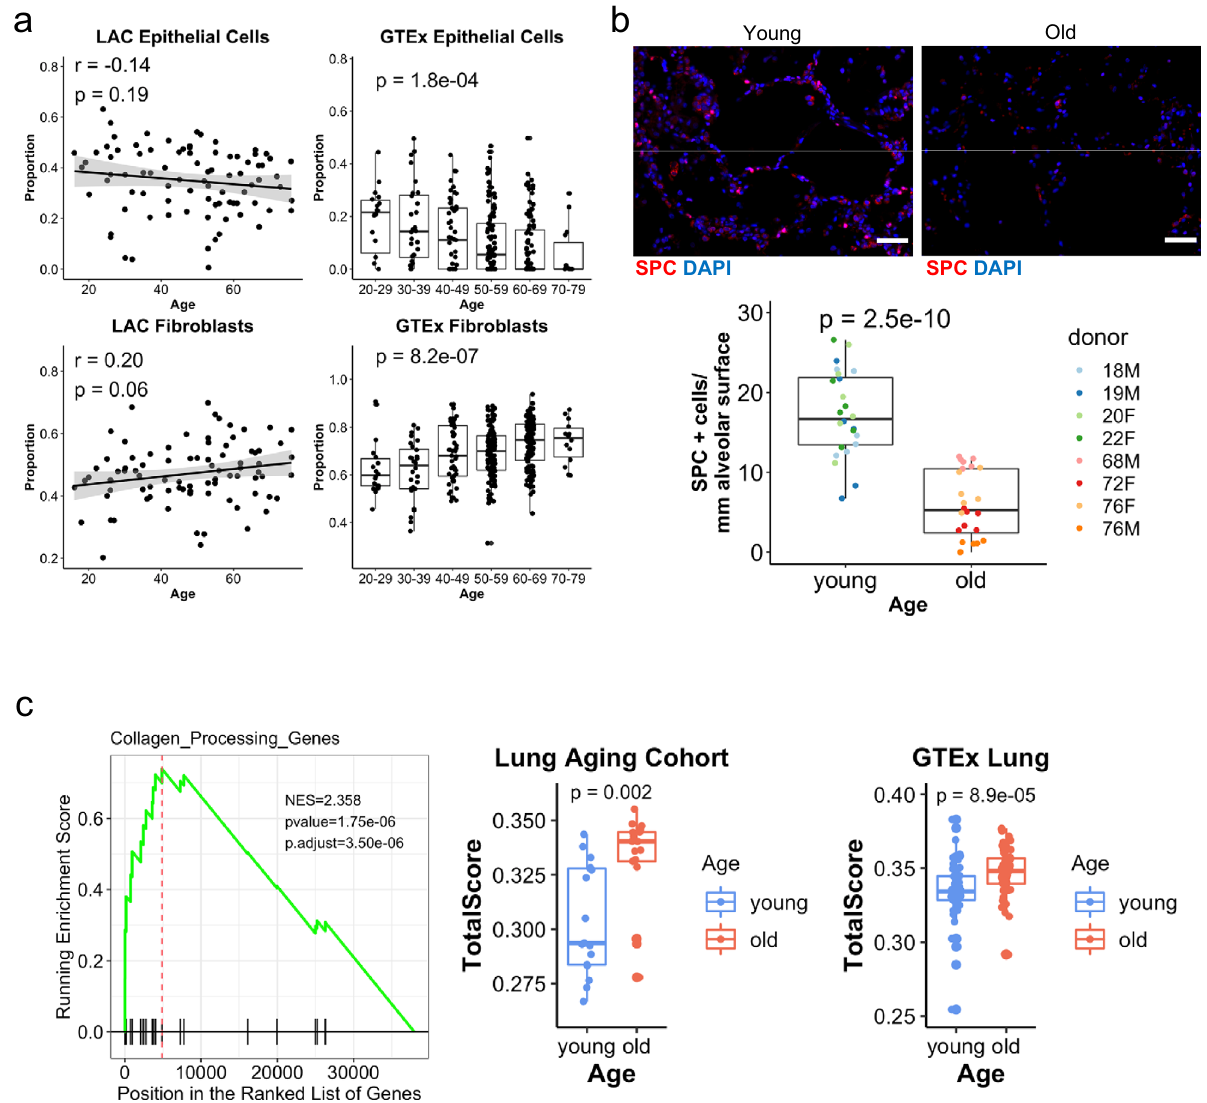
Fig. 3 Fibrotic programs in lung aging. a Cell type deconvolution of bulk RNA-seq data from the LAC ( N = 86 biologically independent samples) and GTEx lung ( N = 345 biologically independent samples). Age for GTEx is represented in decades. Pearson R and P values are shown for LAC, and one-way ANOVA is shown for GTEx. The gray bands represent 95% con fi dence intervals. b Quanti fi cation of type 2 cells in old and young lungs by labeling of SPC + cells, with representative images (Scale bars: 50 µ m) ( N = 4 biologically independent samples in each group, N = 6 images examined per sample). Donor age and gender are shown. Each point represents the number of SPC + cells in a separate image, adjusted for alveolar membrane length. P value is for a two-tailed Student ’ s t -test comparing all dots from the old versus the young. c Collagen-processing gene expression in the LAC by gene set enrichment analysis. Genes were ranked by Pearson R between normalized gene expression and age. Normalized enrichment score, P value, and adjusted P value are shown. Single sample gene set enrichment analysis scores are plotted for the genes enriched in aging (genes listed in Fig. S3a) in the oldest and youngest quintiles from the LAC ( N = 17 biologically independent samples in each group) and GTEx lung ( N = 69 biologically independent samples in each group). P values are for the two-tailed Student ’ s t -test. For boxplots in a – c , the middle line shows the median, the lower and upper hinges are the fi rst and third quartiles, and the lower and upper whiskers extend to the value at most 1.5 IQR below the fi rst quartile or 1.5 IQR above the third quartile, respectively. Data beyond the end of the whiskers are outlying